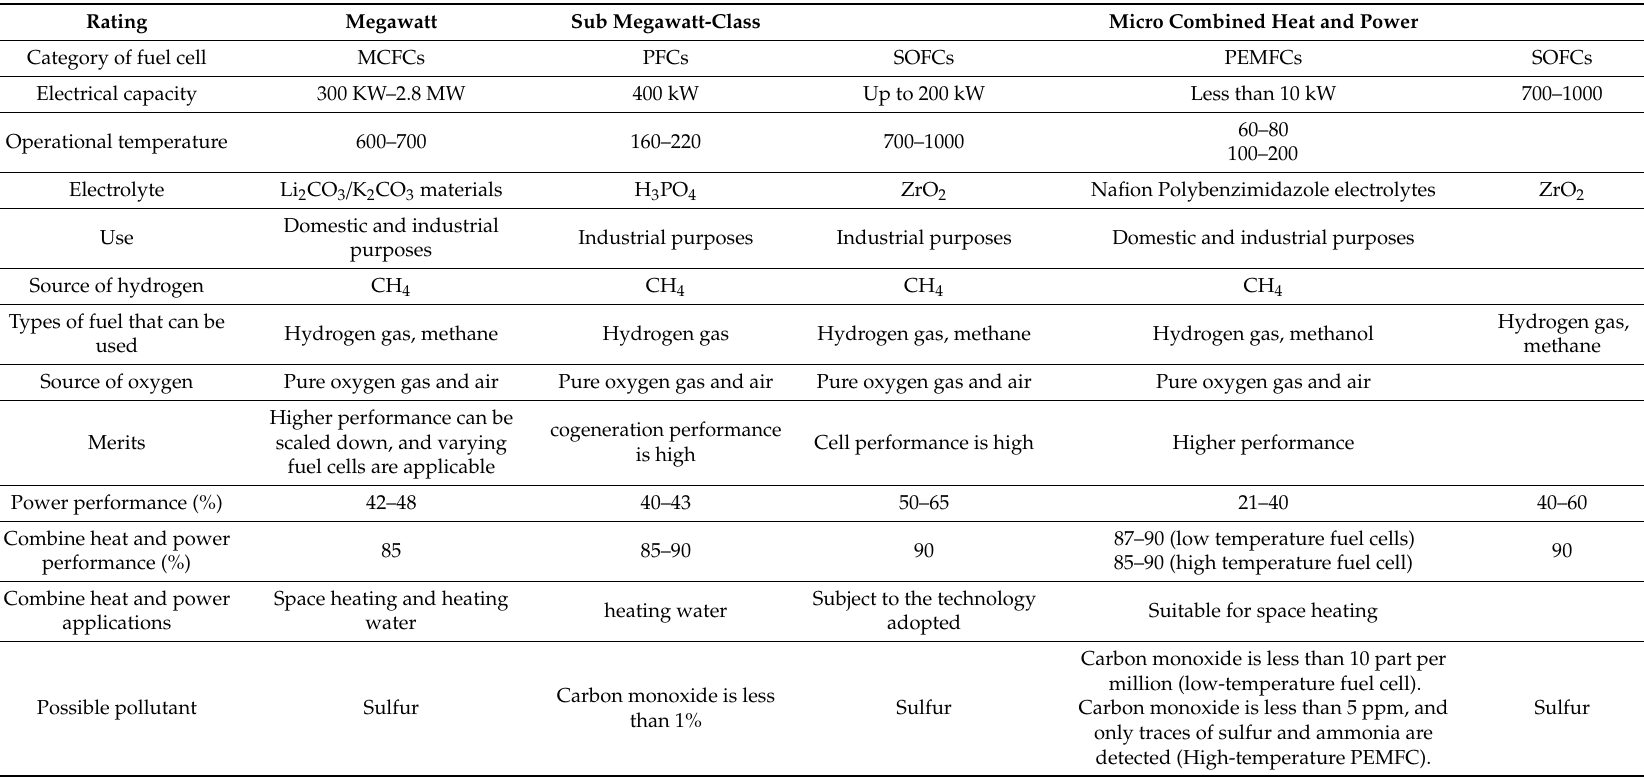
Table 1. Classification of fuel cell combined heat and power “FC—CHP” subject to the range of power